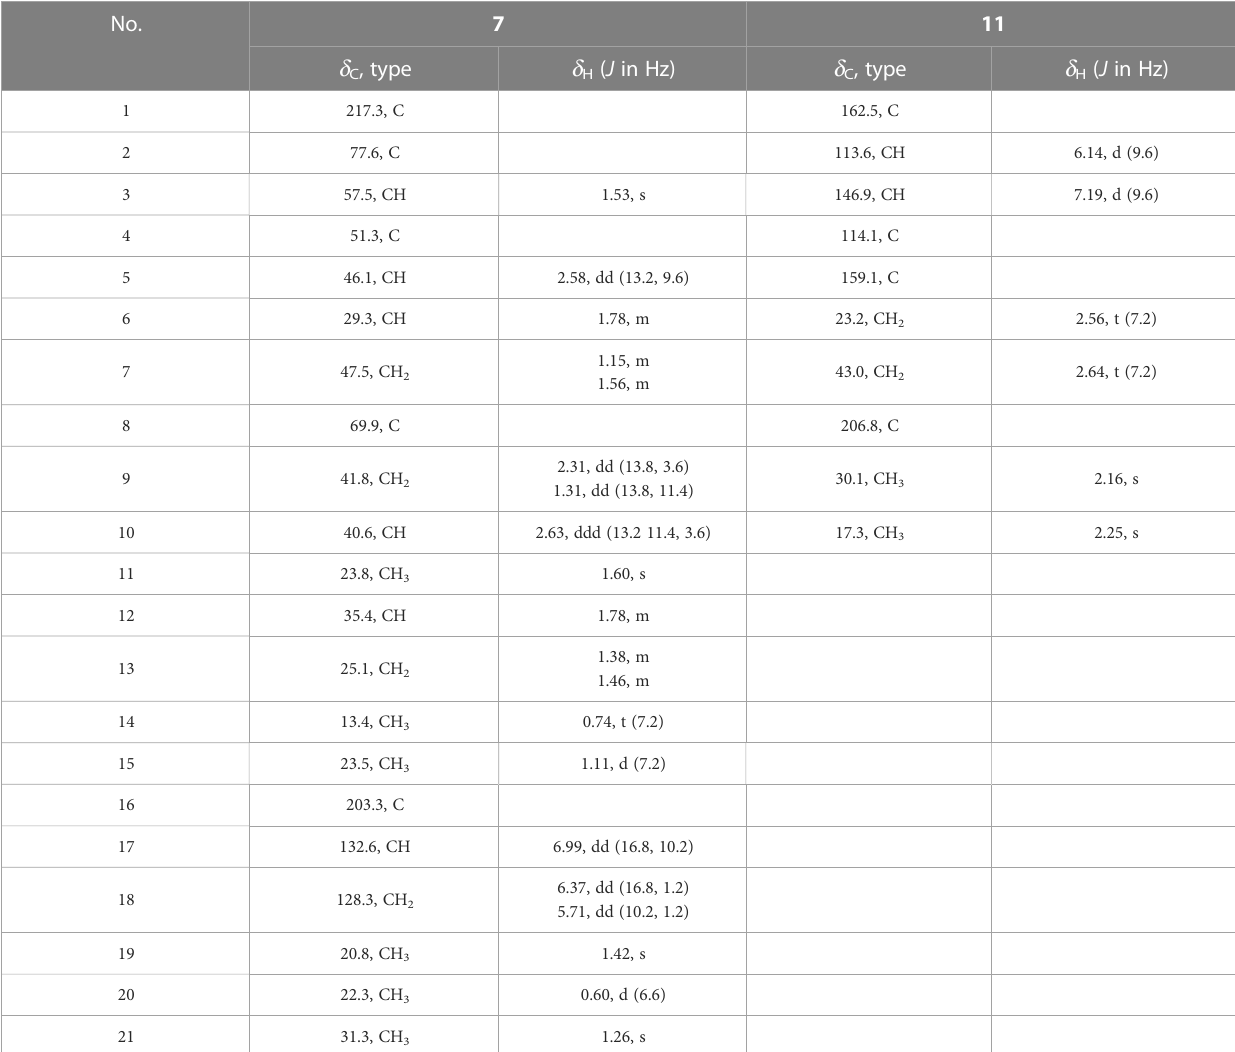
TABLE 2 1 H- (600 MHz) and 13 C-NMR (150 MHz) data for compounds 7 and 11 in CDCl 3 .